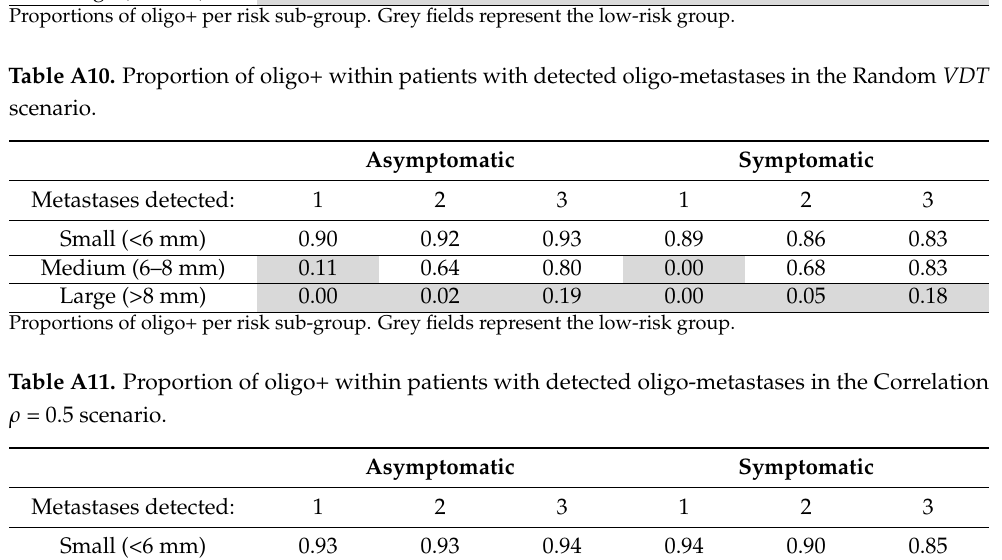
Proportions of oligo+ per risk sub-group. Grey fields represent the low-risk group. Table A12. Proportion of oligo+ within patients with detected oligo-metastases in the Correlation ρ = 1.0 scenario.